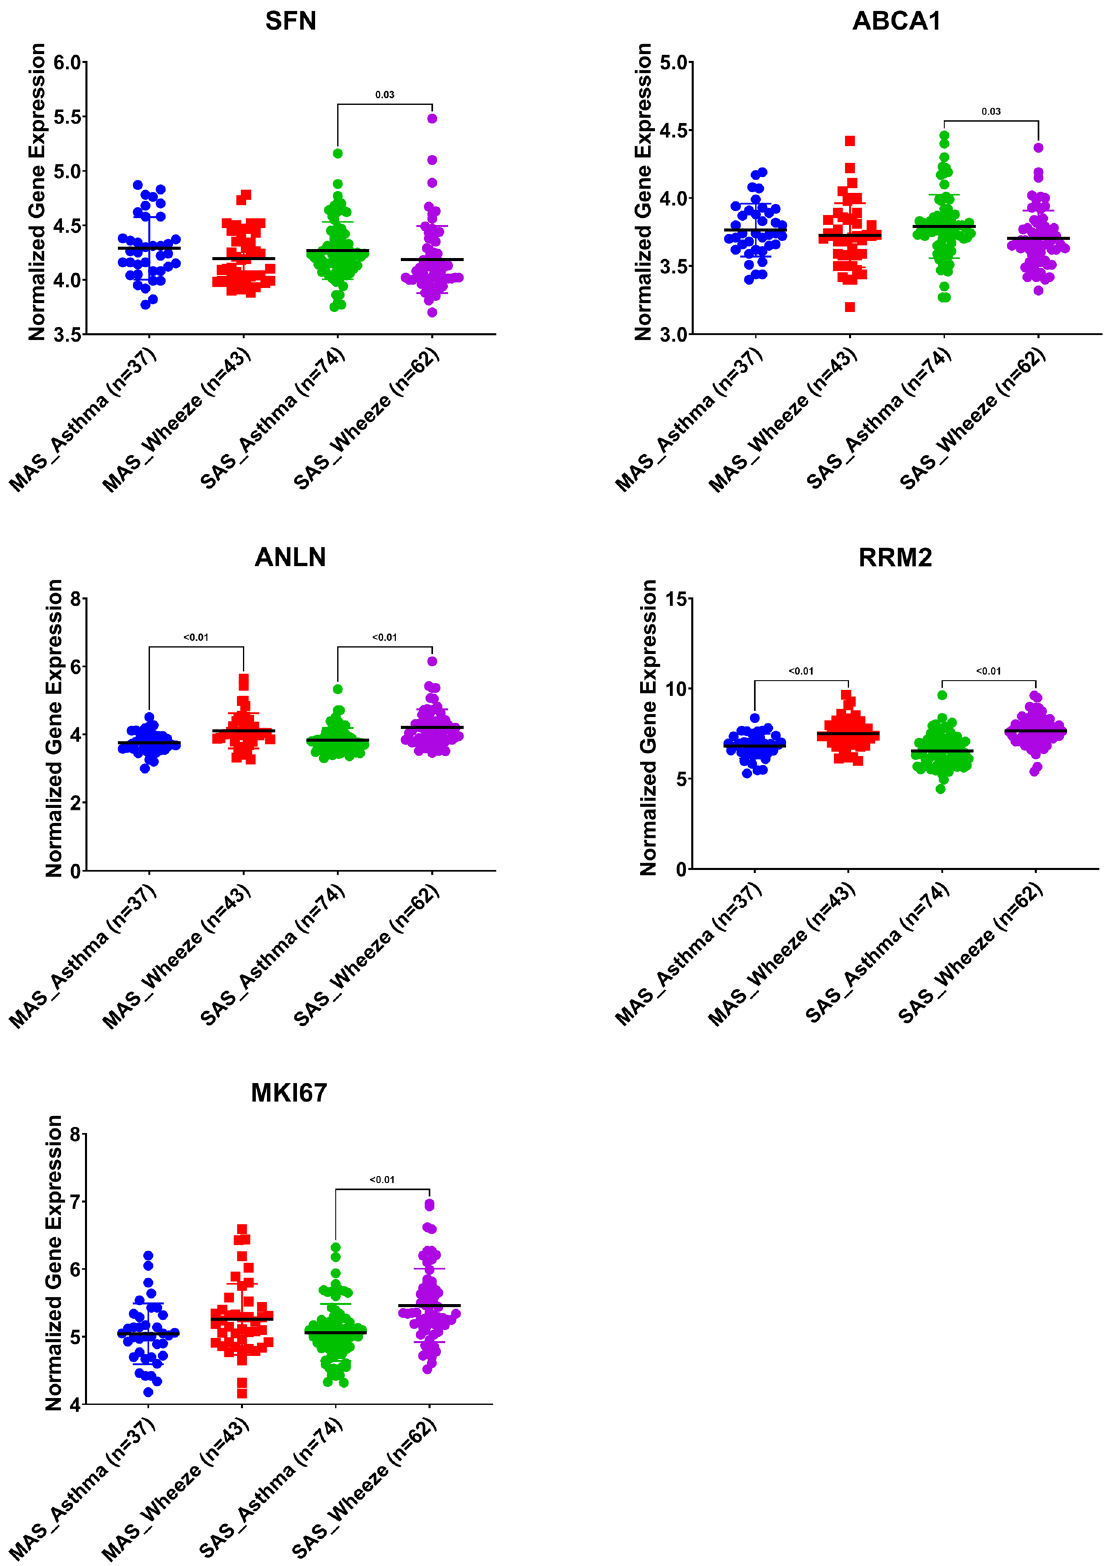
Figure 7. Normalized gene expression of genes identified in whole blood of children with nonsevere and severe wheezes were compared to nonsevere and severe asthmatics extracted from the expression profile of publicly available datasets (GSE123750), where nonsevere asthmatic (MAS_Asthma) and severe asthmatic (SAS_Asthma) patients were compared to patients presented with nonsevere wheezes (MAS_Wheeze) and severe wheezes